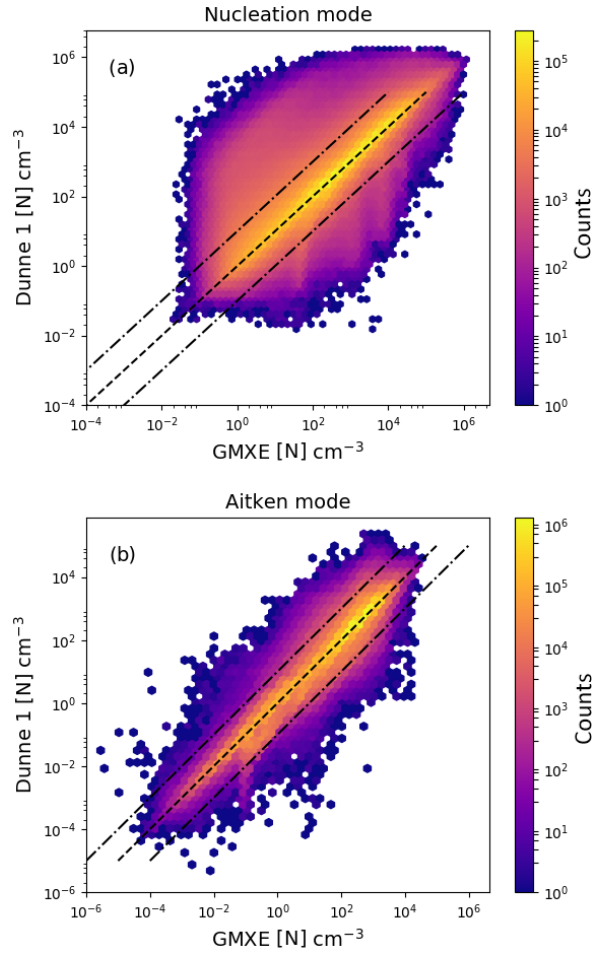
Figure 6. Logarithm of the aerosol particle number concentration with the Dunne et al. (2016) nucleation scheme implemented in NAN and called in EMAC after the call of GMXe ( y axis) vs. im- plementation inside the GMXe submodel ( x axis). Panel (a) shows the results for nucleation-mode particles and panel (b) for Aitken- mode particles. The colour indicates the total number of counts in each hexagonal